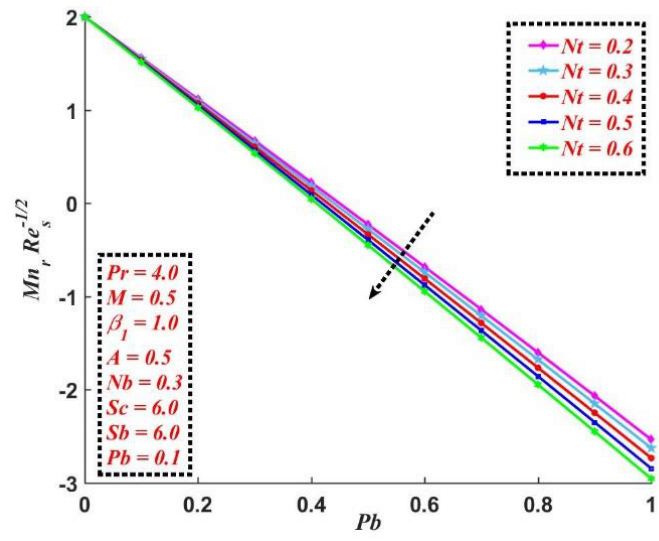
Figure 16. Variation of the motile microorganisms’ number with Nt and Pb .